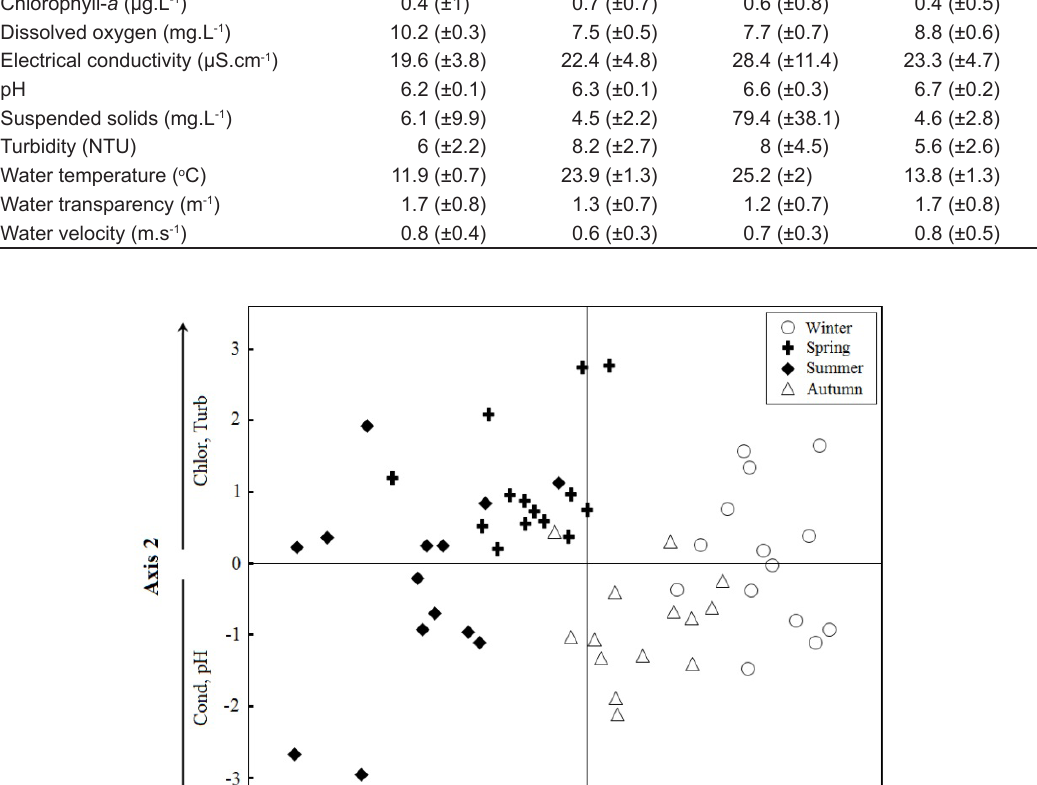
Table 2. Mean values (±standard deviation) of environmental variables during the seasons in the Pelotas River sub-basin. Environmental variables